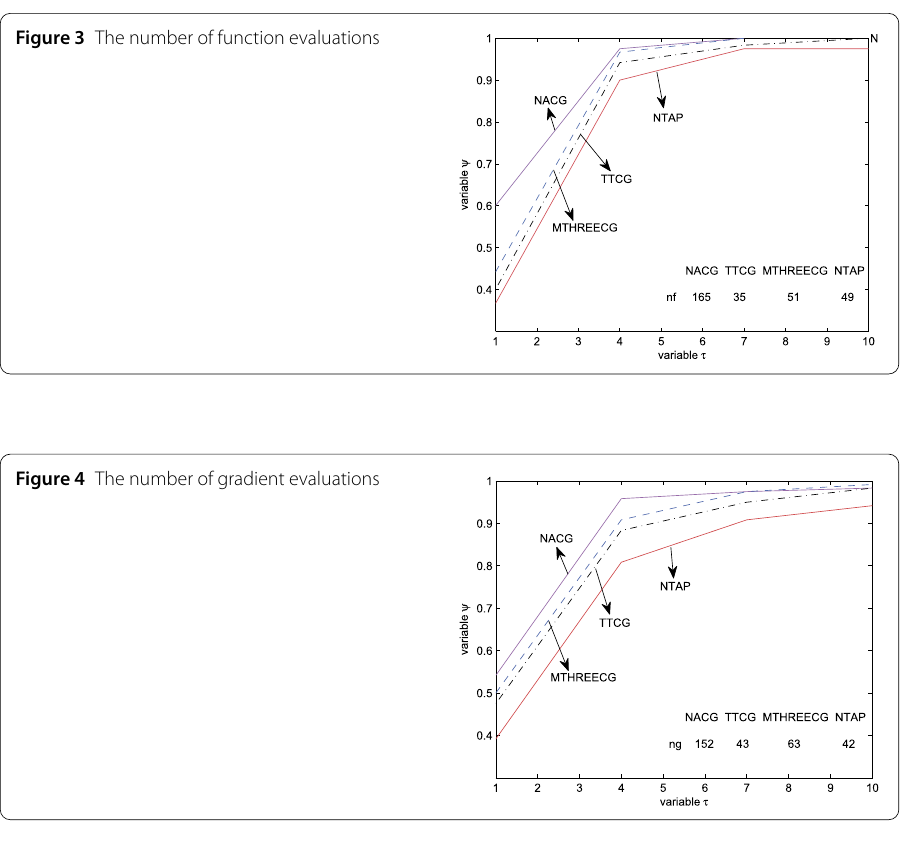
Figure 3 The number of function evaluations